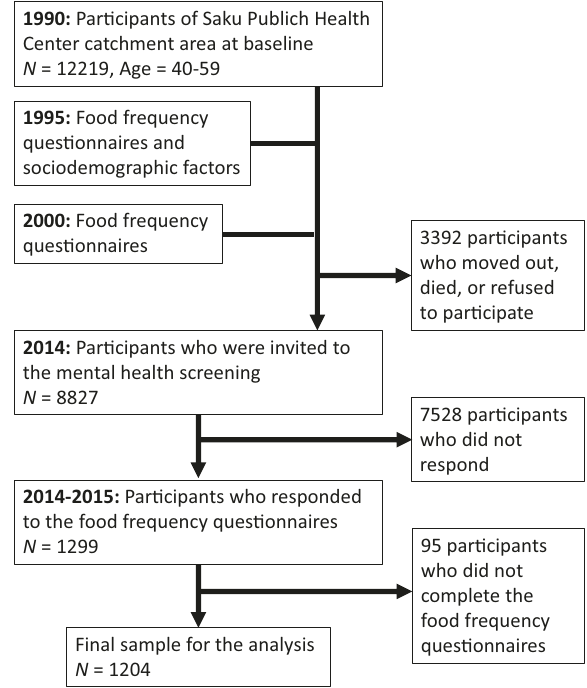
Fig. 1 Flow diagram of study population selection. We included 1204 participants in the fi nal sample.